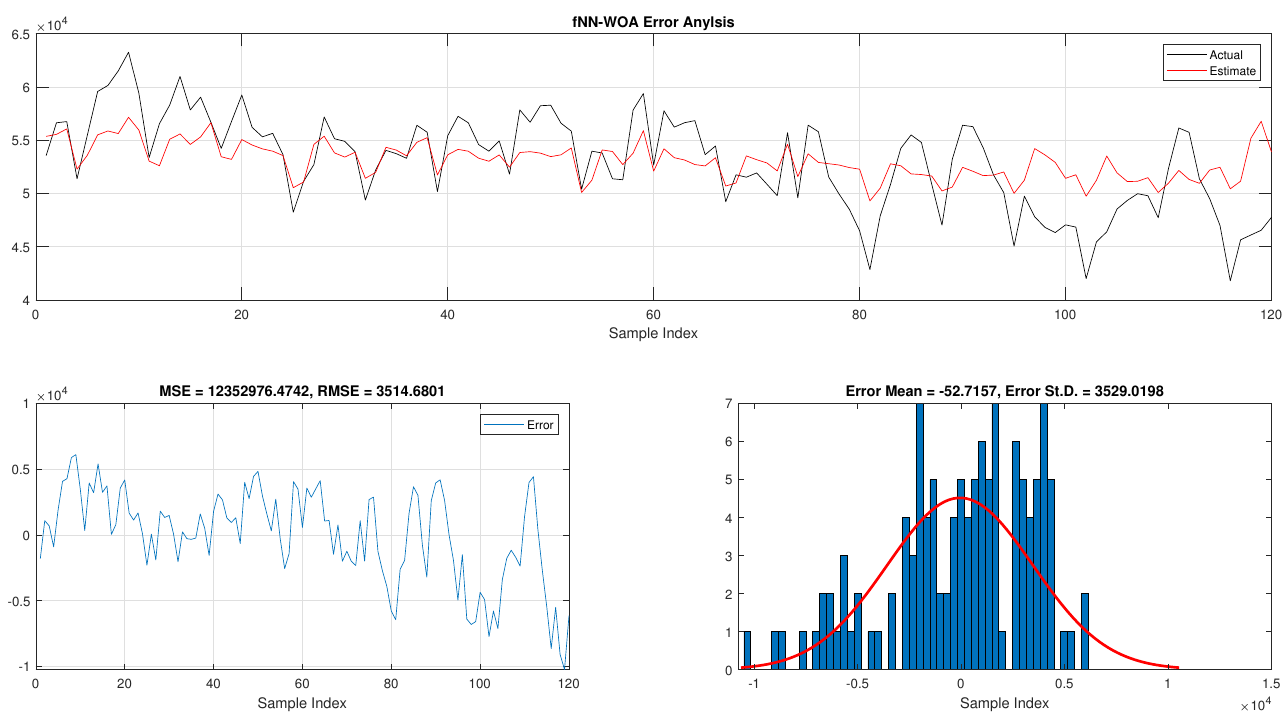
Figure 20. Error analysis of the total daily load consumption with fNN-WOA best